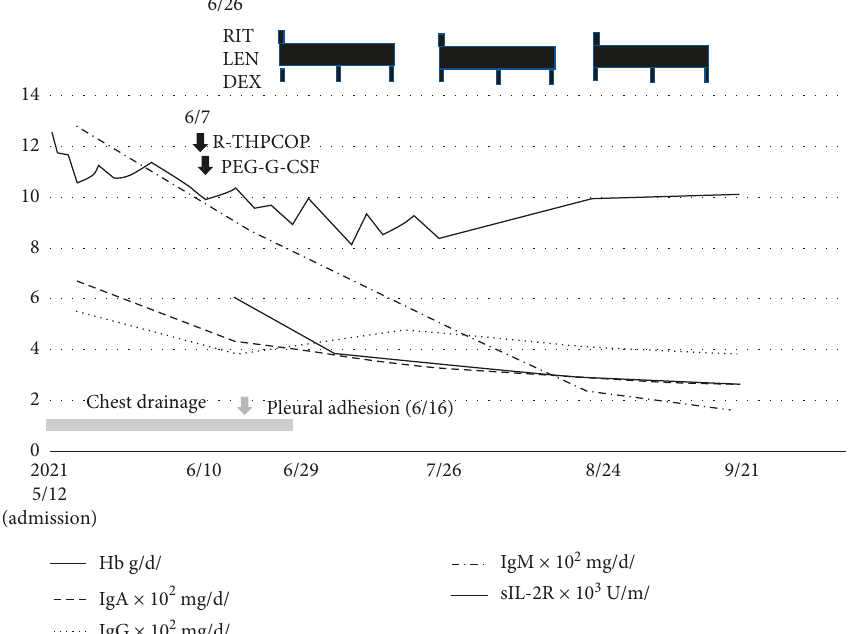
Figure 1: Clinical course. LEN, lenalidomide; RIT, rituximab; DEX, dexamethasone; sIL-2R, soluble interleukin-2 receptor; Hb,